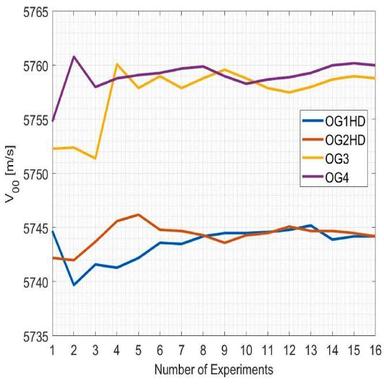
Cumulative mean values of V00 for each sample.